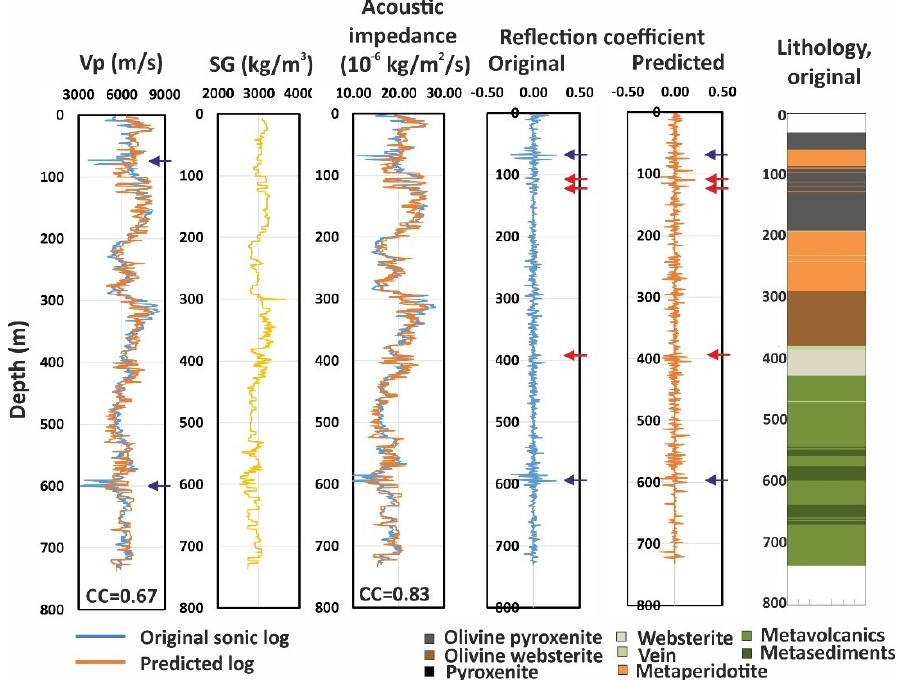
Figure 5. Comparison between actual measured (in blue) and predicted (in orange) log for Vp in test borehole KV171 (Figure 1). The prediction is based on test run 9 (Table 2). Also shown are the SG log and calculated original (measured) and predicted acoustic impedance and reflection coefficients logs. Correlation coefficients (CC) between the measured and predicted logs are shown below the logs. The last column shows the original lithology for the borehole KV171. Blue and red arrows indicate the reflections discussed in the text.